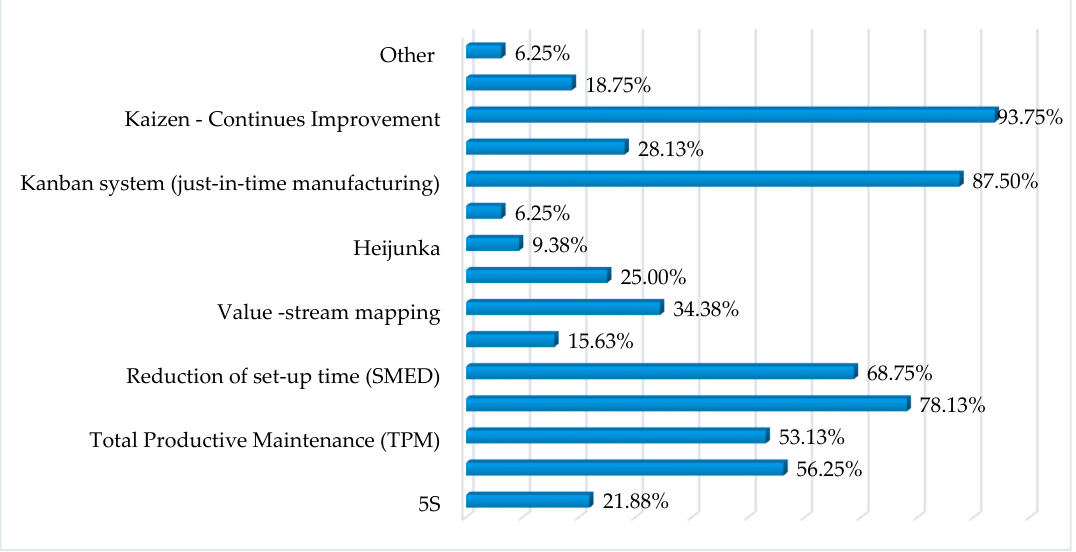
Figure 3. Lean tools that companies are using or have used.